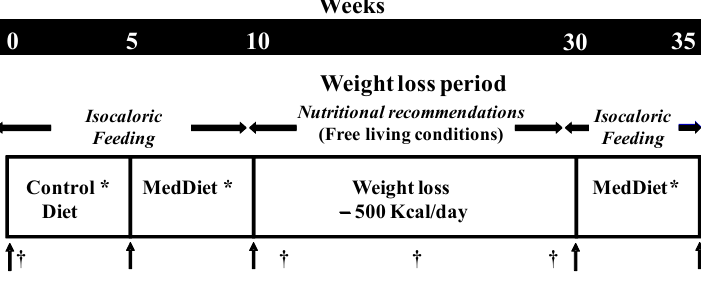
Figure 1. Study design. * Controlled feeding phases of the study (daily weighting and adjustment of energy intake). † Food and physical activity records (three days). ↑ Anthropometric and eating behavior measurements. MedDiet: Mediterranean Diet. Table 1. Composition of the prescribed North American control diet and